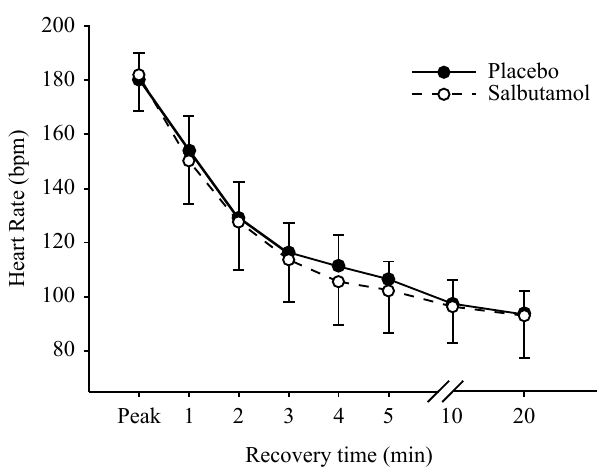
60% and HR 80% by Kar- Target Target